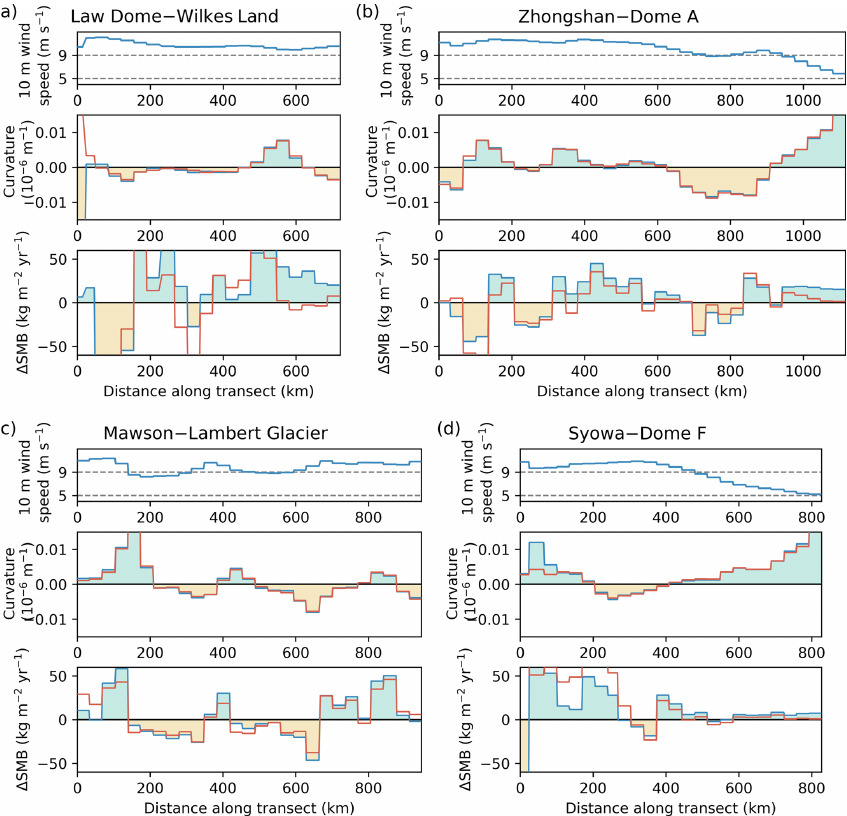
Figure 3. Annual mean 10m wind speed, curvature of elevation, and modelled SMB minus observed SMB for the four long transects: (a) Low Dome–Wilkes Land, (b) Zhongshan–Dome A, (c) Mawson–Lambert Glacier, and (d) Syowa–Dome F. Blue lines and colour shading are for MAR (ERA-Interim) outputs and red lines are for RACMO2 (ERA-Interim) outputs. Values are computed as in Fig.